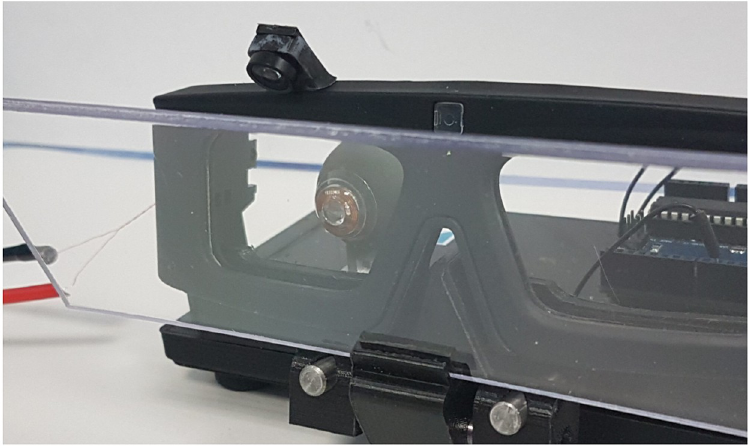
Fig 12. Eyewear in the camera configuration. The camera is mounted on top the eyewear frame. The beam splitter allows positioning the camera virtually in front of the eye.